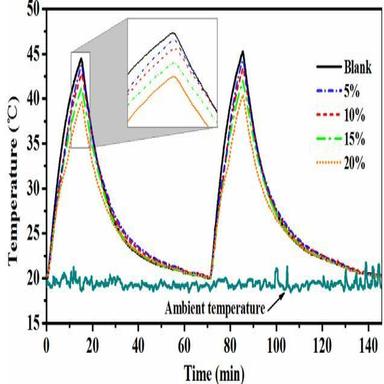
The heat transfer analysis of TSCM mortars.